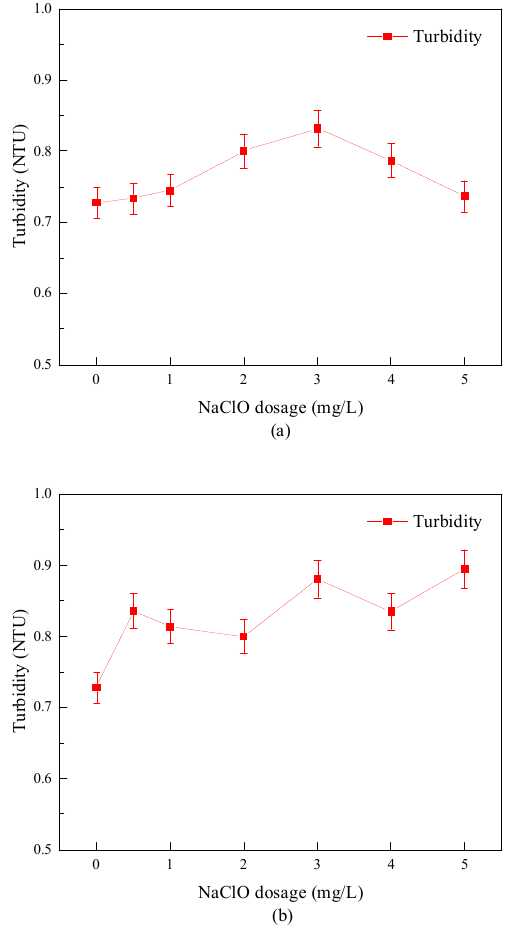
Figure 8. Turbidity removal effect of combined disinfection method. ( a ) “Method A”; ( b ) “Method